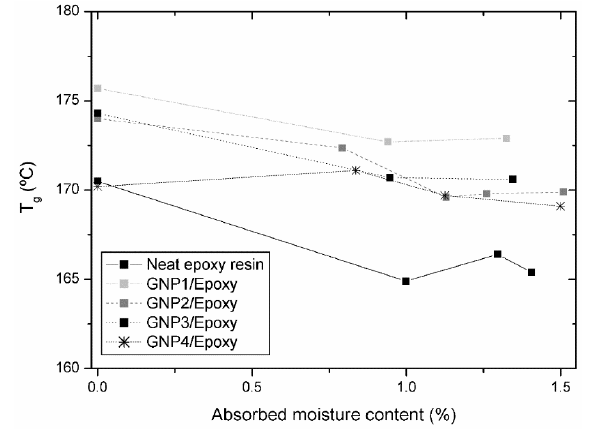
Figure 5. Decrease of glass transition temperature due to the water absorption.